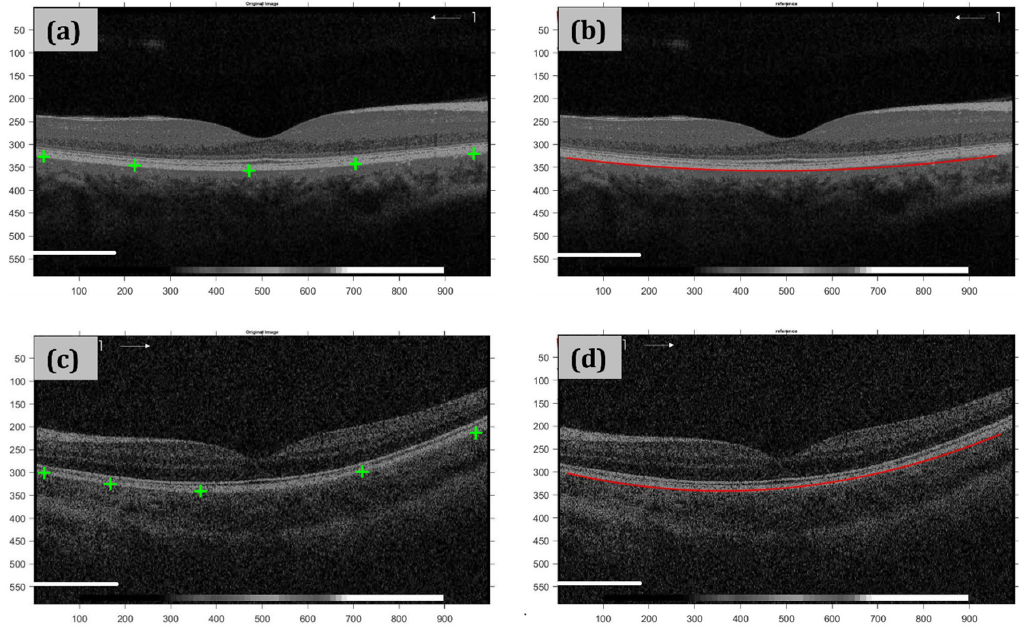
Figure 3. OCT Example of detection of RPE in two different OCT images ( a , c ) and final conical segmentation ( b , d ). Scale bars 1000 µm.